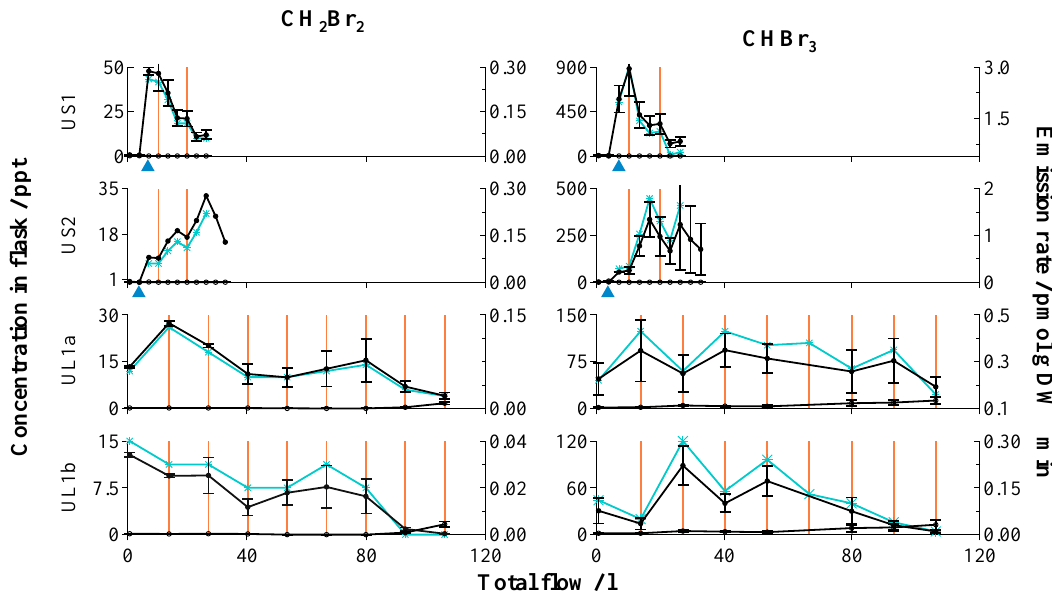
Figure 5. Bromocarbon concentrations (ppt, left axis) and production rates (pmolgDW − 1 min − 1 , right axis) observed in flasks during desiccation of U. intestinalis (US and UL experiments). All other details are as for Fig. 4.